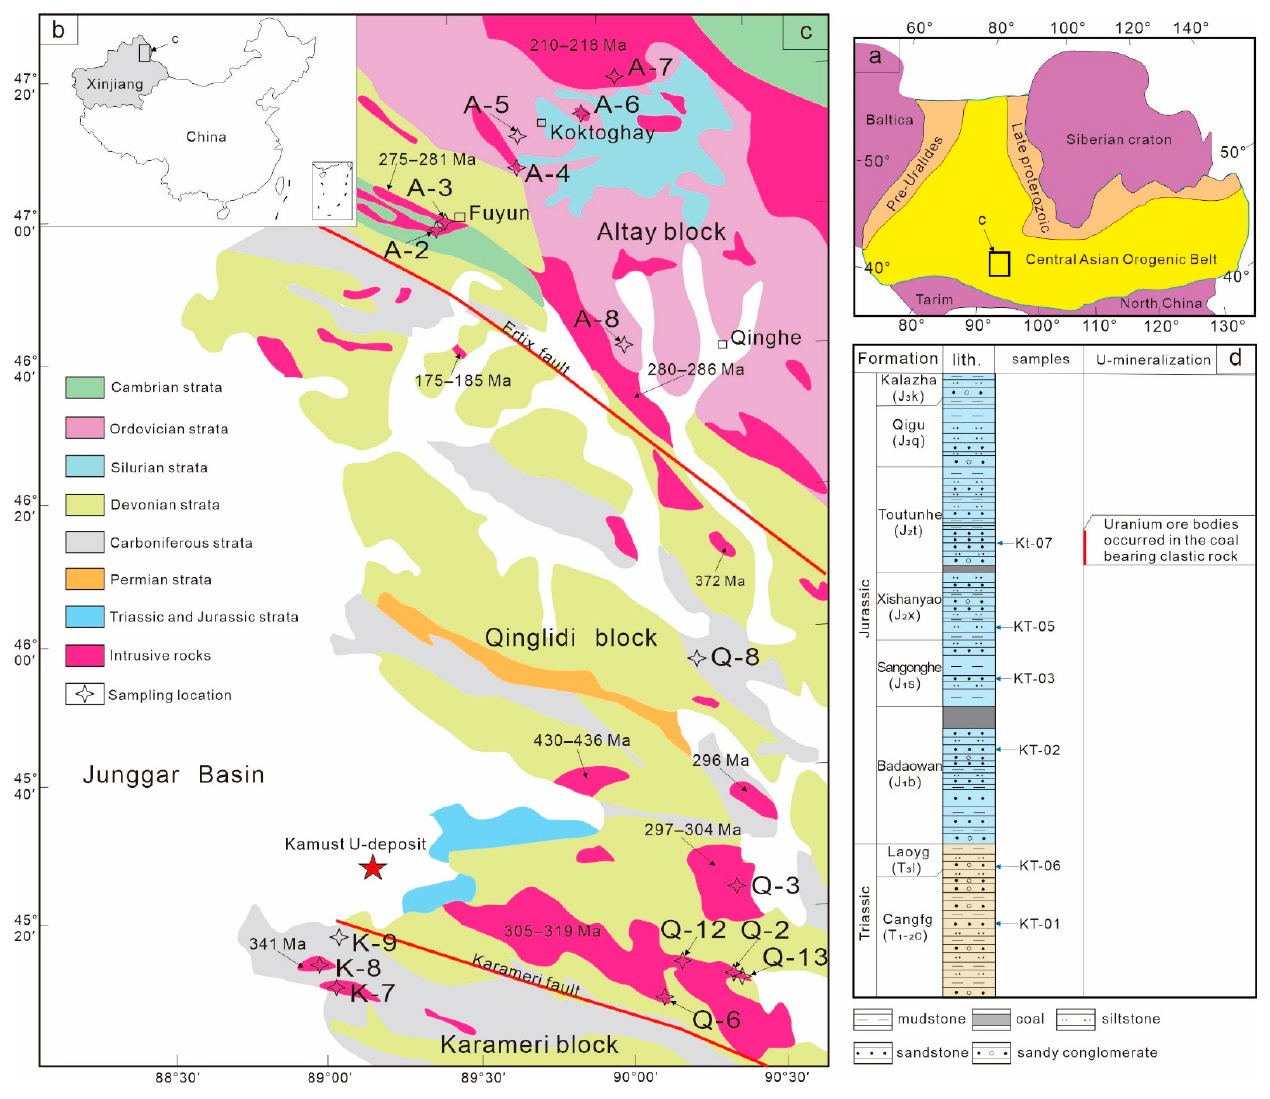
Figure 1. ( a ) Tectonic Relationship of the Junggar Basin with the Central Asian Orogenic Belt (modified from [24,35]). ( b ) Map of China, the Junggar Basin is located in Northwest China. ( c ) Simplified geological map of the eastern Junggar Basin and the magmatic rock ages [36–45], showing that the orogenic belt was divided into the Karameri, Qinglidi, and Altay blocks by the Karameri and Ertix faults. ( d ) Comprehensive lithologic histogram of the Kamust uranium deposit. Uranium ore bodies occurred in coal-bearing clastic rocks of the Toutunhe Formation (J 2